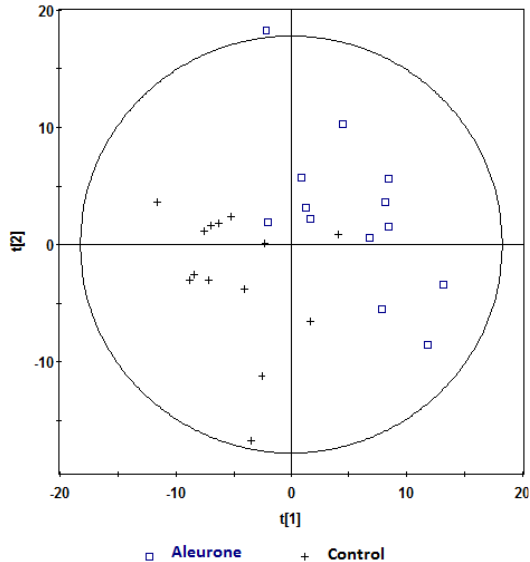
Figure 3. PLS-DA scores plot (t[1]) vs. t[2]) obtained from 1 H NMR spectra of postprandial urine samples of aleurone vs. control at one hour (Observations, n = 27), , aleurone; , control. Variables (K) = 181. PLS component 1: R 2 = 0.196, Q 2 = 0.315; PLS component 2: R 2 = 0.18, Q 2 = 0.117. The ellipse represents 95% confidence region of the model based on Hotelling T 2 .